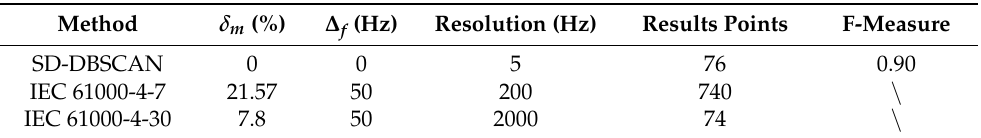
Figure 13. The measured signal was analyzed by the proposed method, IEC 61000-4-7 (method A), and IEC 61000-4-30 (method B). Table 6. Results of the measured signal processed by the proposed method, IEC 61000-4-7, and IEC 61000-4-30.